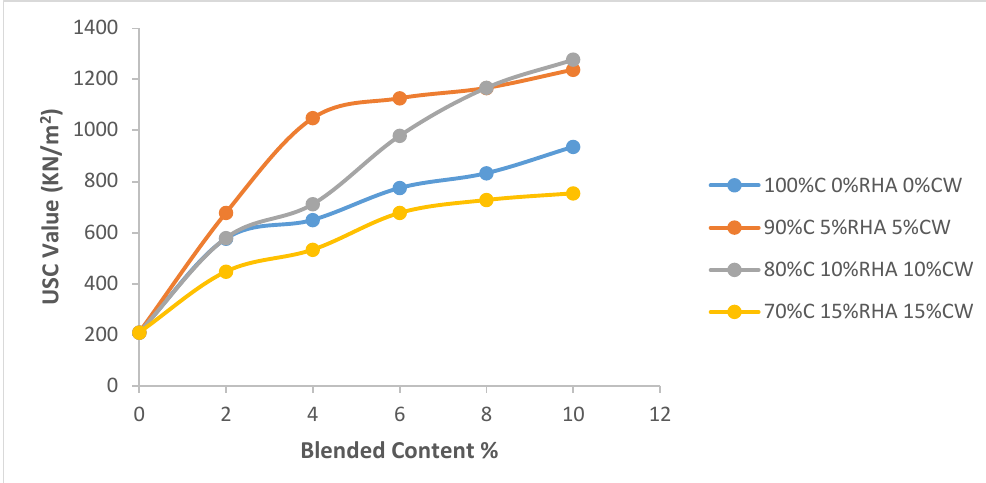
Fig. 10. Relationship between the 7 days UCS values of laterite treated with (100%C 0%RHA 0%CW), ( 90%C 5%RHA 5%CW),(80%C 10%RHA 10%CW)& (70%C 15%RHA 15%CW) blend of